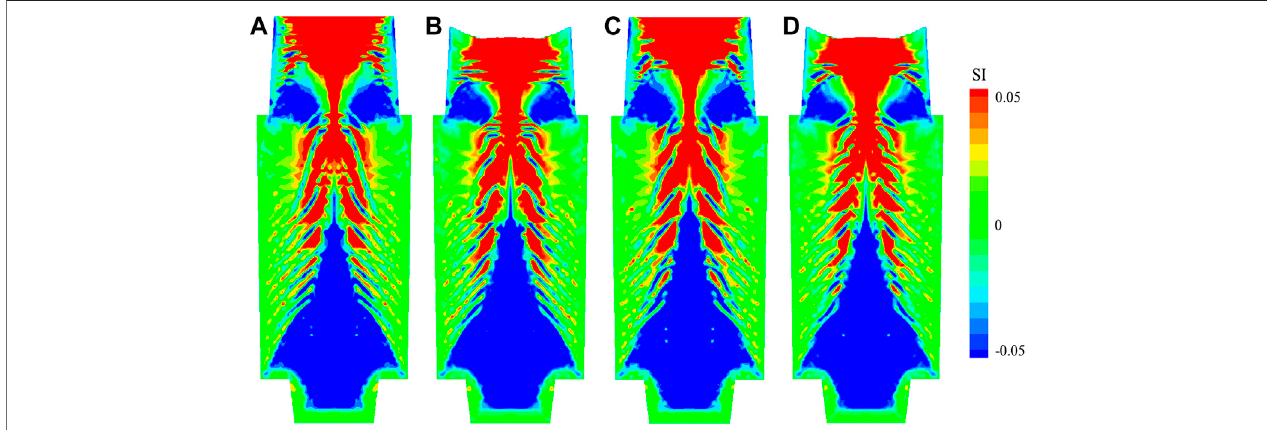
FIGURE 11 | Comparison of segregation index (SI) between measurements and simulation results in a cross section of the ingot: (A) along the centerline; (B – D) along the horizontal lines at the heights of 0.6 m, 1.8 m, and 2.8 m respectively.